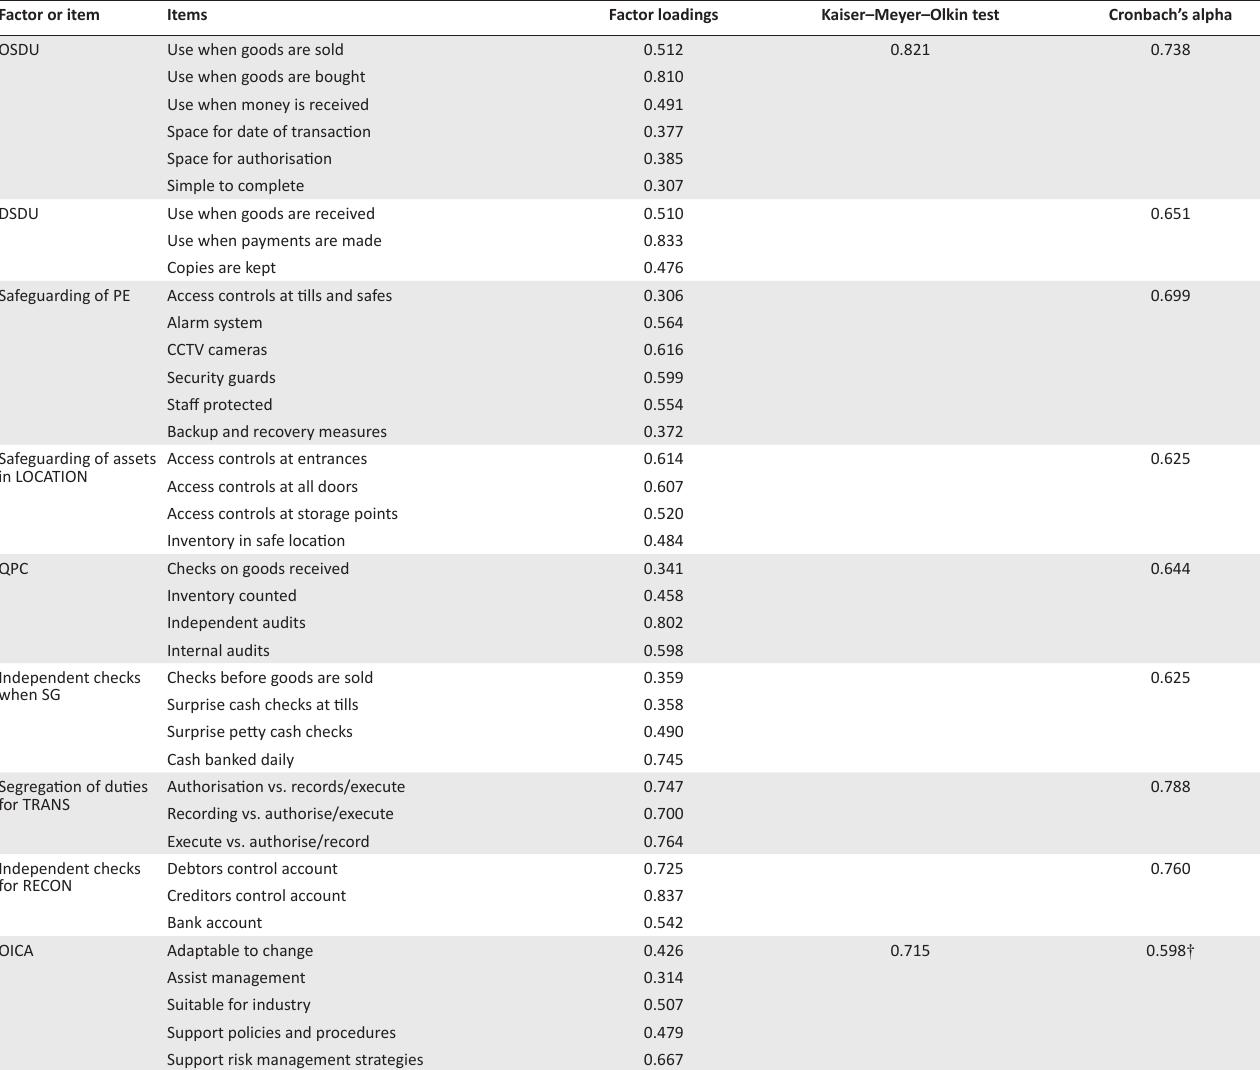
TABLE 1-A1: Summary of principle axis factoring for factors included. Factor or